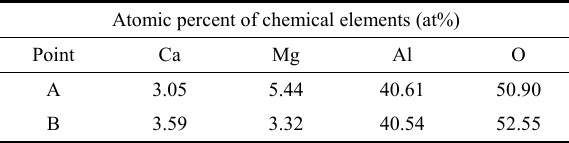
Table 2 EDS results of the points in Fig.